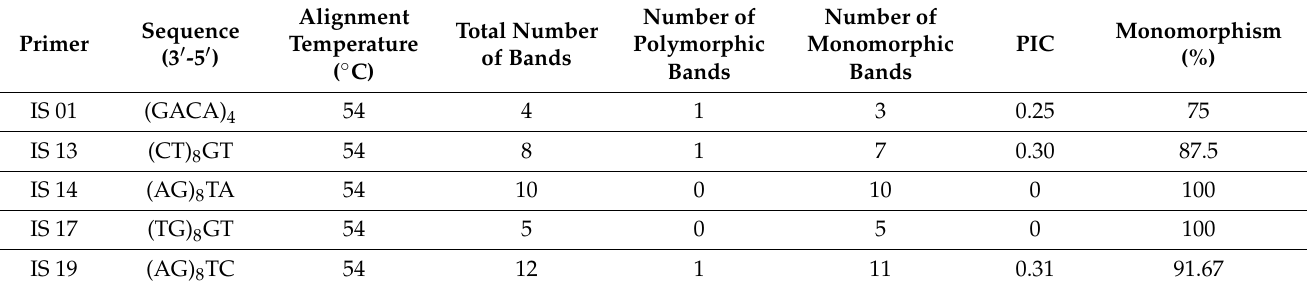
Table 4. ISSR primers [20] used in this study, alignment temperature used in the PCR, and the number of monomorphic and polymorphic bands obtained with each primer, PIC value, and percentage of